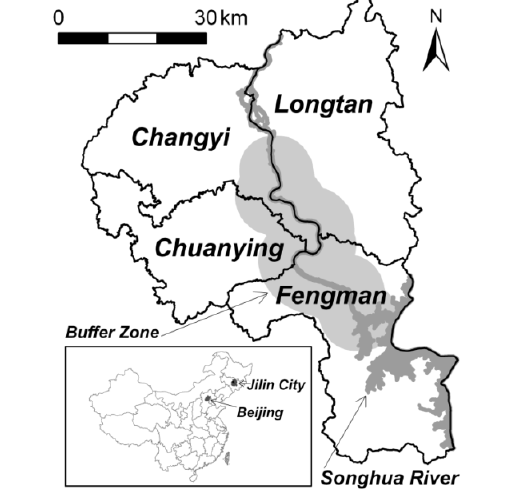
Figure 1. A map of the study area: the four districts of the metropolitan Jilin City and the buffer